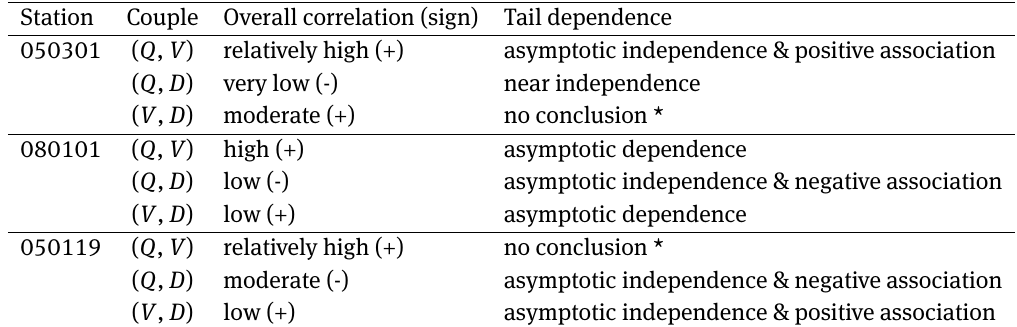
Station Couple Overall correlation (sign) Tail dependence